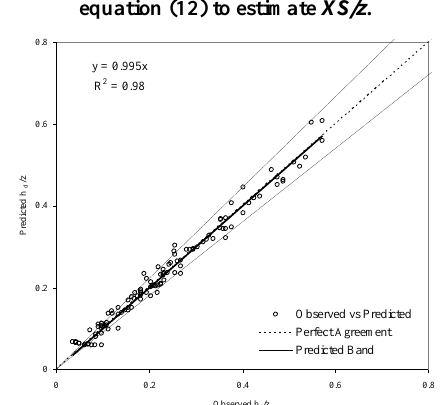
Figure 5. Comparison between observed and predicted equation (13) to estimate h d /z .